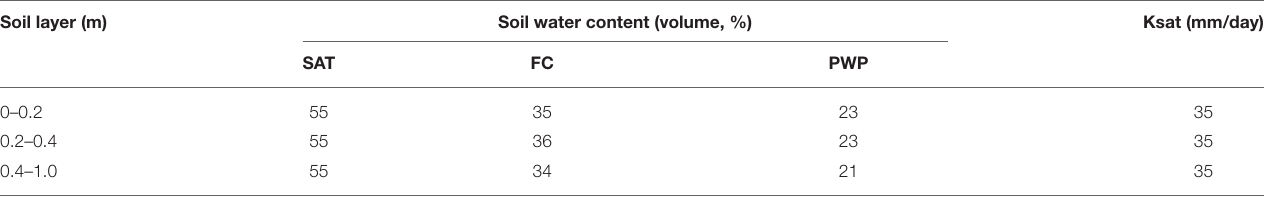
TABLE 1 | Soil physical properties of the experimental fields at Barneb 2 small-scale irrigation scheme in Northeastern Ethiopia. Soil layer (m)